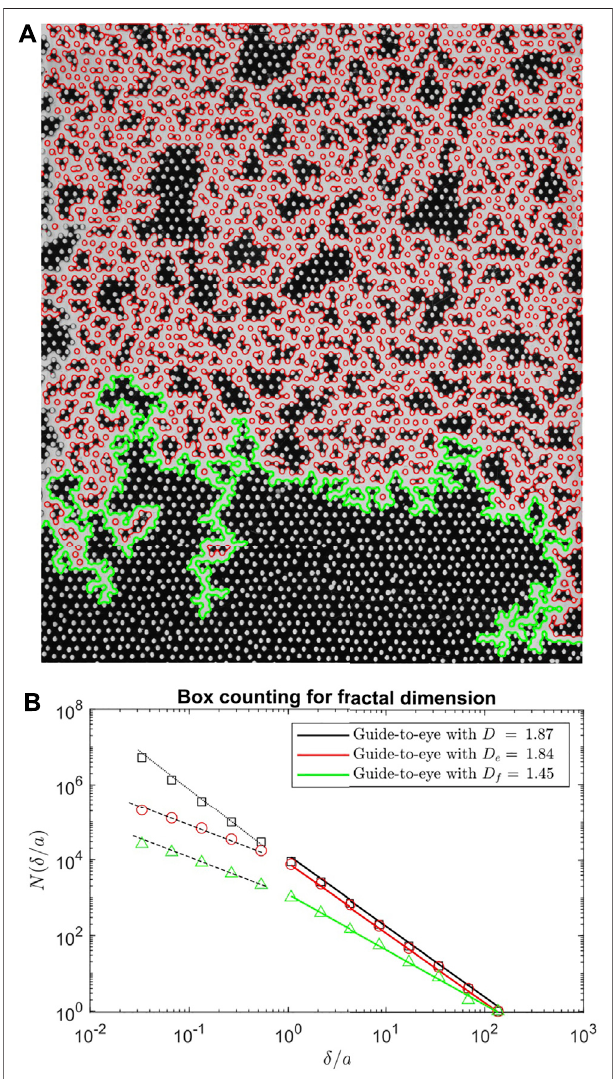
FIGURE 4 | (A) Tracking of the invasion front (green) and of the in-plane invasioncontoursleftbehindtheinvasionfront(red).Noticethatsomeisolated beads are included in the tracking. (B) Measurement of mass fractal dimension D , the fractal dimension D e of the invasion contours and the fractal dimension D f of the main invasion front (green line). The dotted and dashed lines have slopes of − 2 and − 1 respectively.